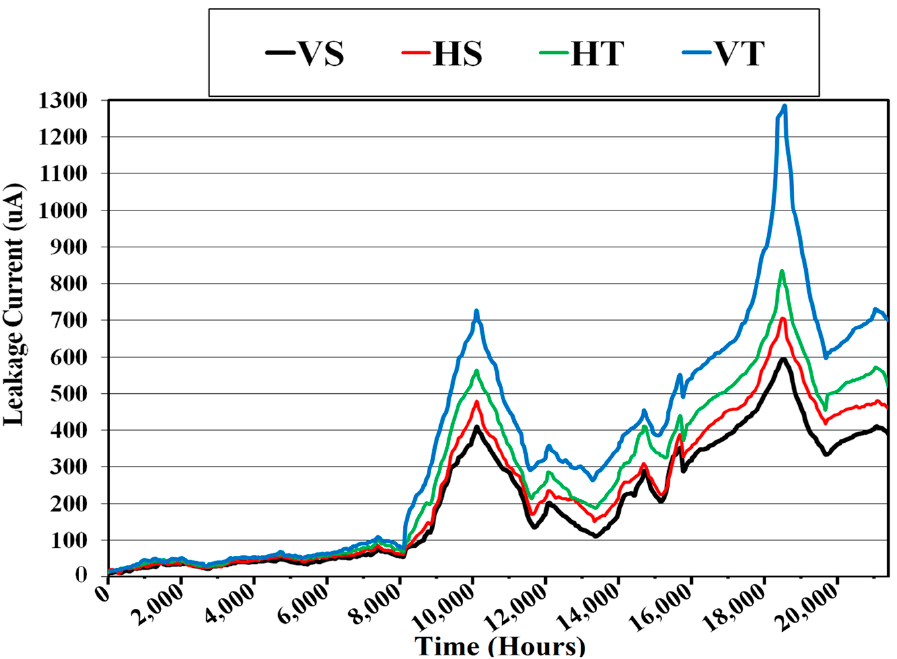
Figure 6. Leakage current variation.